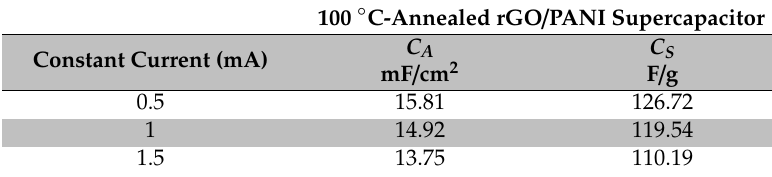
Table 2. Calculated areal and specific capacitance based on GCD